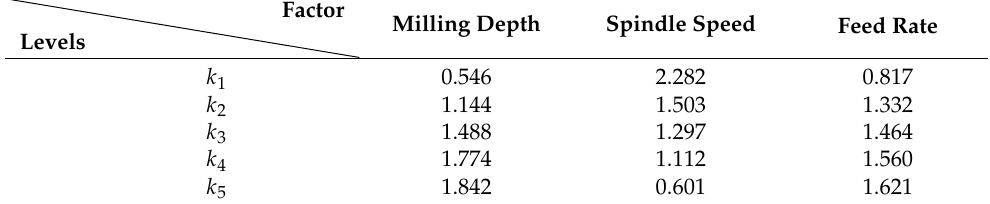
Table 7. Visual analysis results of surface roughness orthogonal experiment.